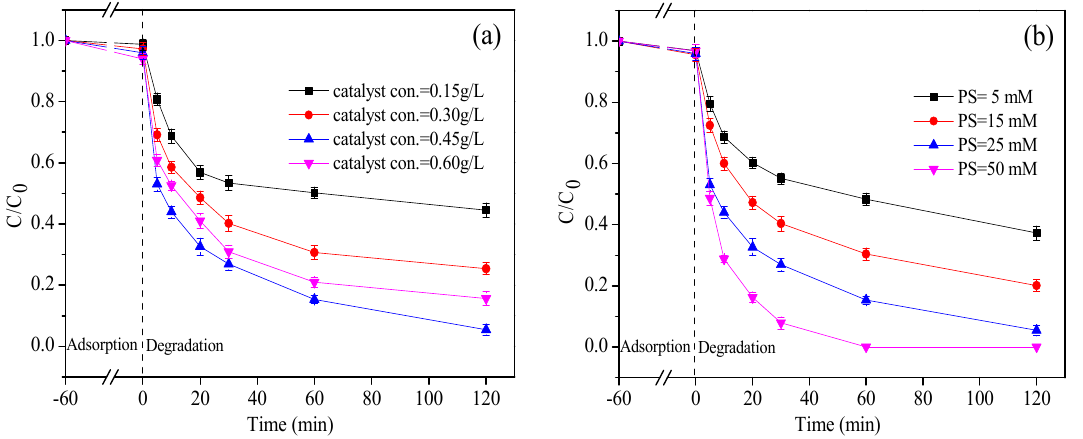
Figure 7. ( a ) Effect of nZVI/2BC dosages on the degradation of DTZ; ( b ) Effect of PS concentrations on the degradation of DTZ. [DTZ] = 20 mg L − 1 ; Temp = 25 °C; pH = 7.0; [PS] = 25.0 mM for ( a ) or [nZVI/2BC] = 0.45 g L − 1 for ( b ).